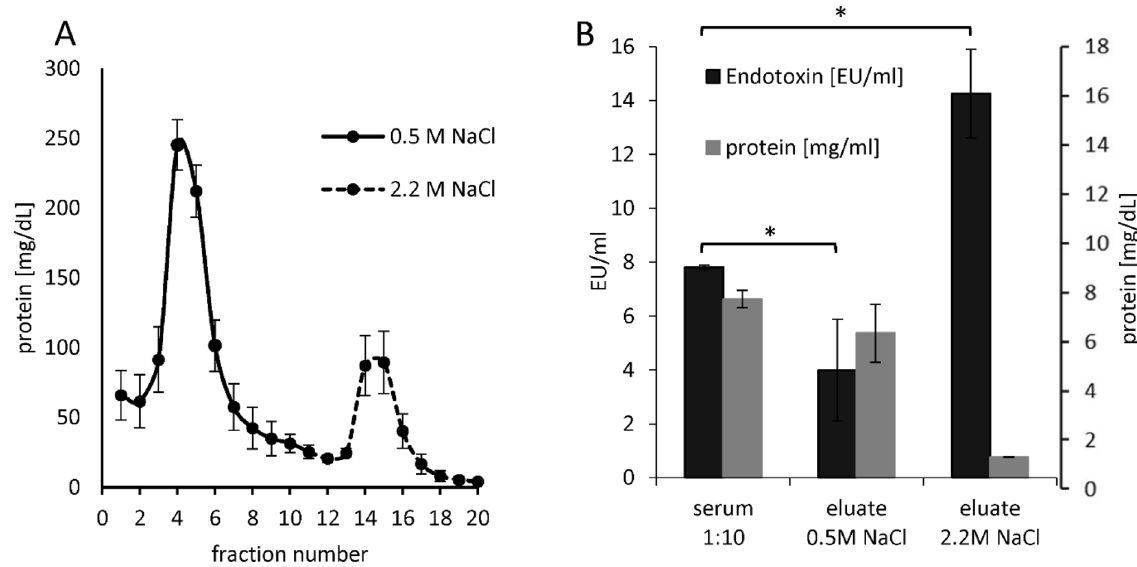
Figure 15. Separation of heparin-binding plasma substances and testing for their ability to mask endotoxins. 25 mL freshly donated serum was pumped through a 5 mL column filled with heparin-immobilized adsorbent at a flow rate of 0.5 mL/min. After washing the column with physiological saline solution, heparin-binding plasma components with medium affinity were eluted using 10 mL 0.5 M NaCl solution. The substances strongly bound to heparin were eluted with 2.2 M NaCl solution. The eluates were separated into 1 mL fractions and their protein content was determined ( A ). The respective fractions of the two eluates were pooled and transferred into ringer solution. An endotoxin recovery of 5 ng/mL LPS ( E. coli ) in the two eluates and in serum diluted 1:10 with ringer solution was then performed using the LAL test ( B ). The bars marked with * indicate a significant (p < 0.05) different in endotoxin recovery. Mean ± standard deviation of three independent experiments with serum from three different donors are shown.